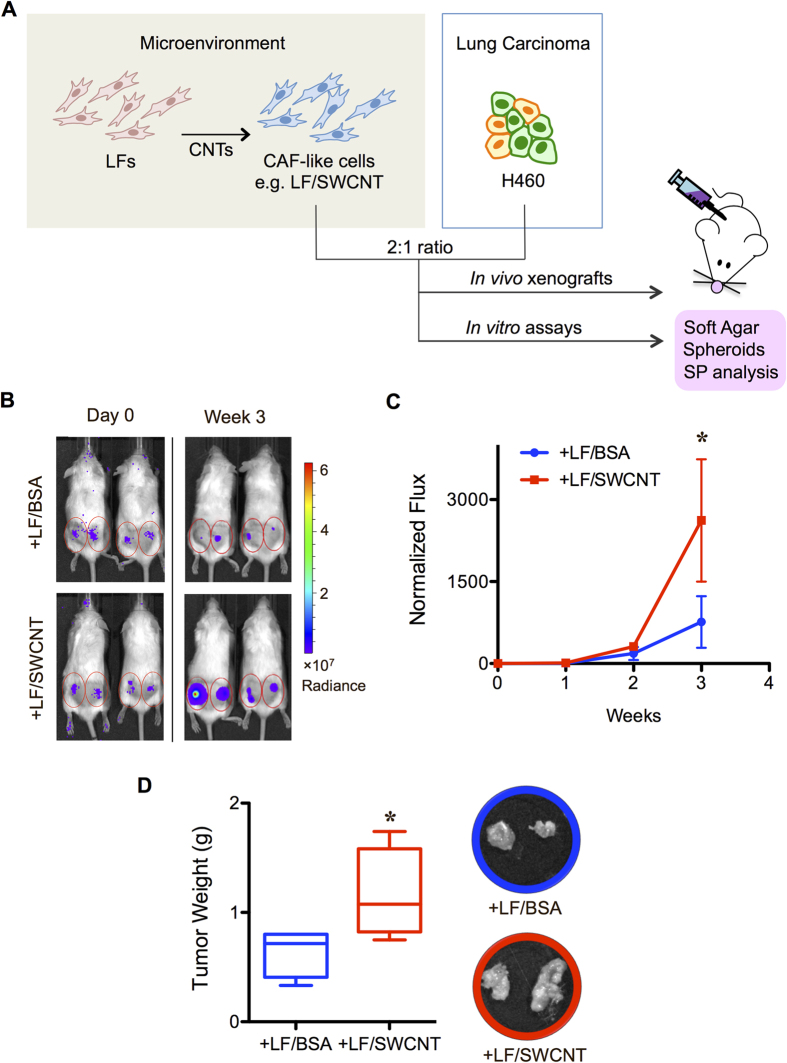
Carbon nanotube-induced cancer-associated fibroblast-like cells promote tumor formation of human lung carcinoma H460 cells.(A) Schematic diagram depicting methodological steps of in vivo and in vitro co-culture experiments. (B) SWCNT-induced cancer-associated fibroblast-like cells (LF/SWCNT) or vehicle-treated fibroblasts (LF/BSA) at the dose of 6 × 105 cells were co-injected with luciferase-labeled H460 cells at the dose of 3 × 105 cells (2:1 ratio) into the left and right flanks of NSG mice. Tumor formation was monitored weekly by IVIS bioluminescence imaging. IVIS images of mice at day 0 and week 3 are shown. (C) Normalization of tumor bioluminescence signals at various time points post-injection to their initial signals at day 0. (D) Subcutaneous tumors were dissected from mice bearing H460 and LF/SWCNT or LF/BSA, and weighted at the end of experiments at 3 weeks post-injection. Data are mean ± SD (n = 4). *P < 0.05 vs H460 and LF/BSA group.